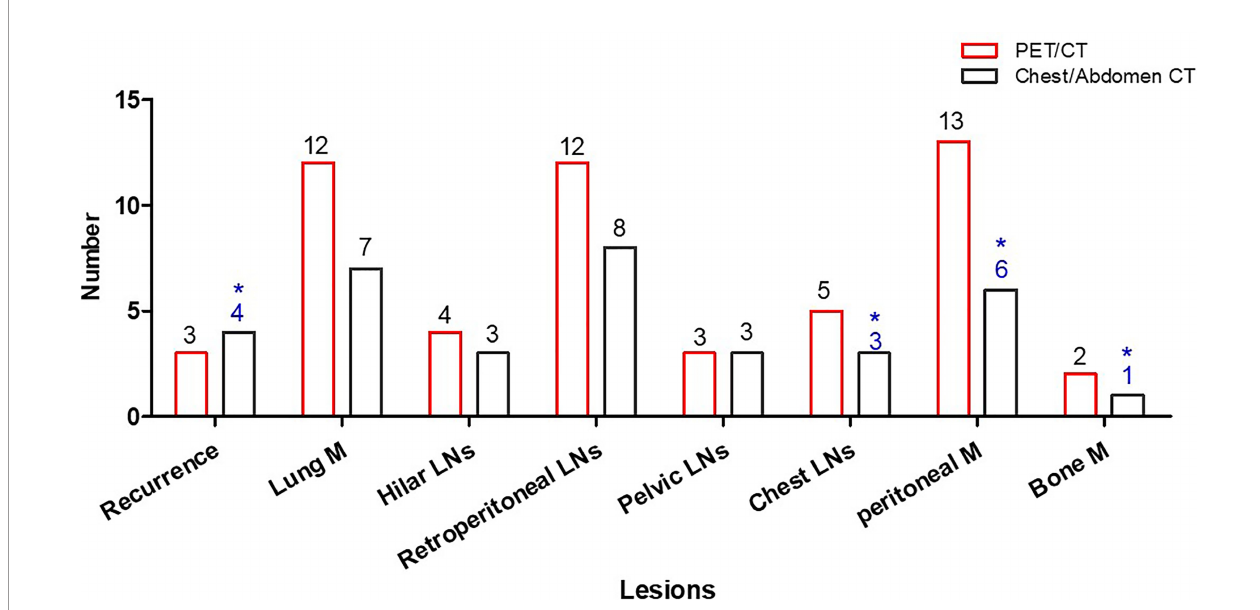
FIGURE 3 | Patient number with EHD detected by PET/CT and common CT. Common CT had false-positive results in four patients (*).